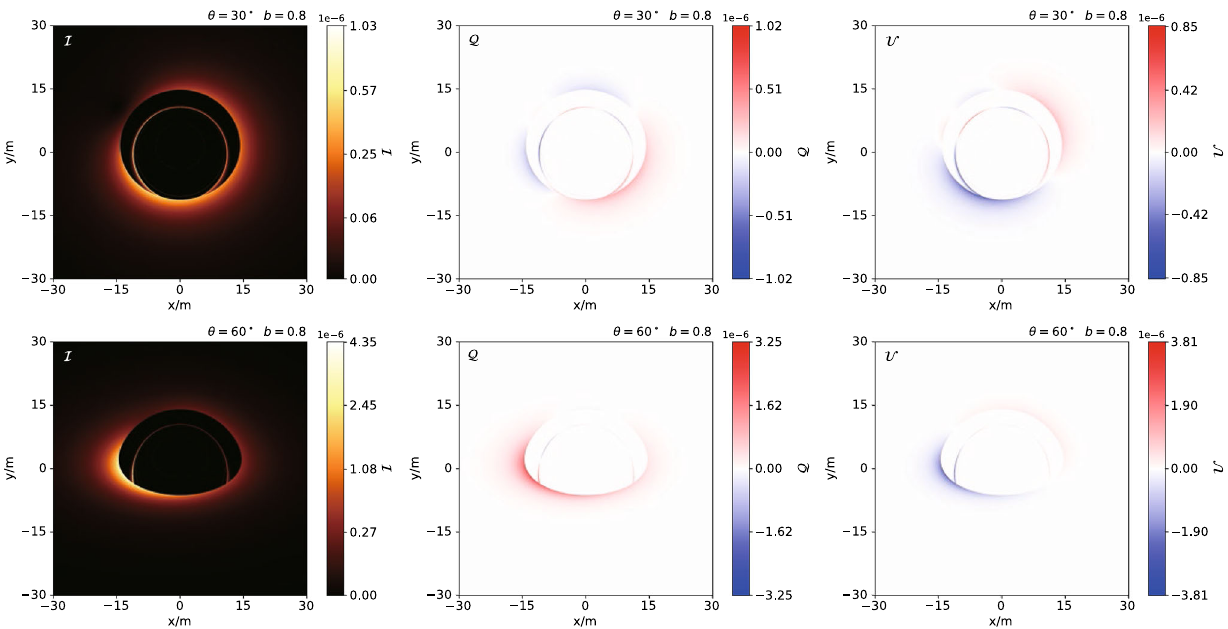
Fig. 8 The distribution of the observed polarization intensity I , the angle ζ and the redshift g with x along the line y = 0 in Fig. 6 and 7